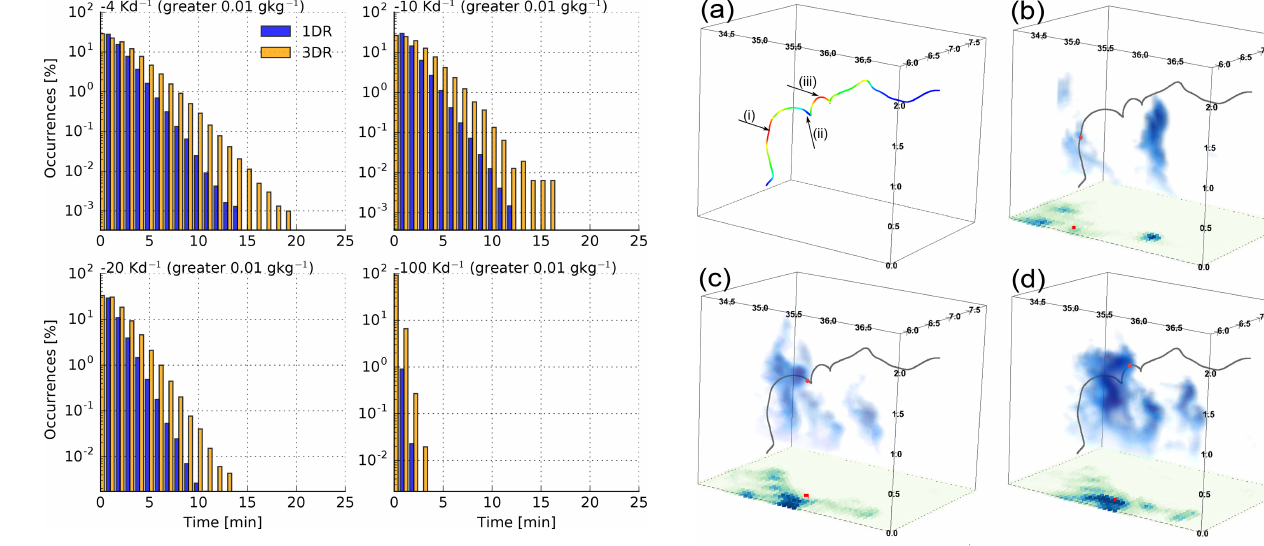
Figure 3. Histogram of the time that parcels spend at cloud top or cloud side. For the sampling of the data, a threshold of 0.01gkg − 1 of the q c was used to separate cloudy from non-cloudy regions. To separate cloud edge regions from the cloud interior, four different thresholds of the cooling rates were used (4, 10, 20, 100Kd − 1 ).